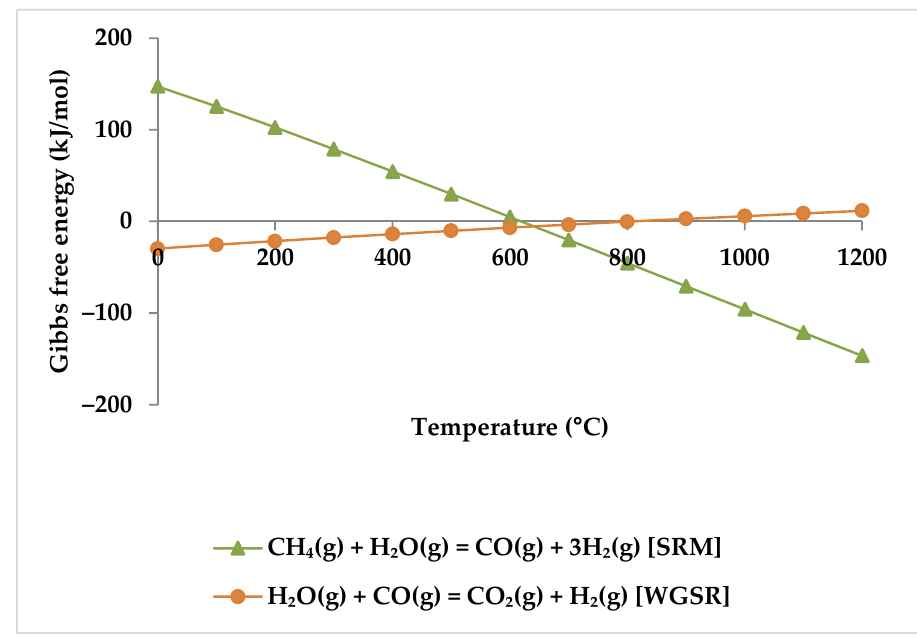
Figure 12. Gibbs free energy diagram for SRM and WGSR.